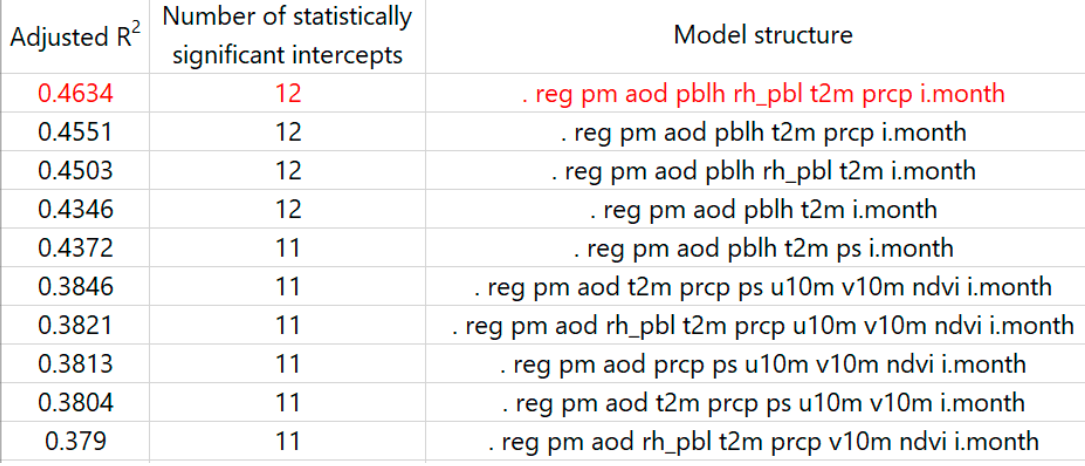
Figure A3. Screenshot of determining the best model structure for the TFER model with